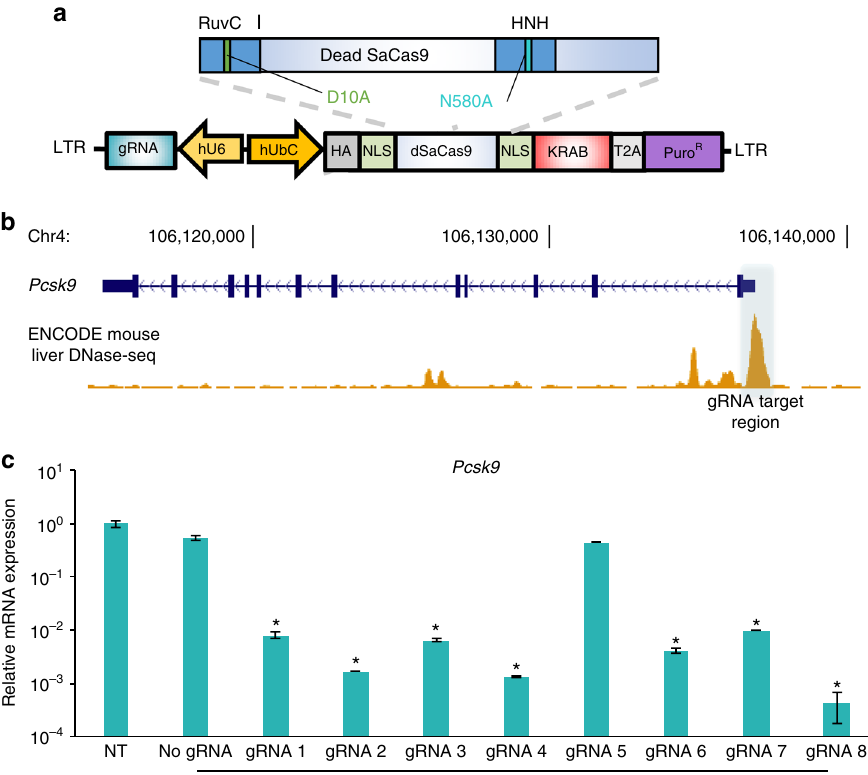
Fig. 1 Targeted gene silencing of endogenous Pcsk9 in vitro. a Deactivated S. aureus dCas9 was fused to a KRAB repressor motif and delivered by lentivirus for in vitro gRNA screening. The lentiviral vector also contained a puromycin resistance gene and a gRNA expression cassette. b A panel of eight S. aureus gRNAs were designed to target the accessible chromatin region of the mouse Pcsk9 promoter region in AML12 cells, a mouse hepatocyte cell line with high expression of Pcsk9 . An ENCODE wild-type mouse liver DNase I hypersensitivity-sequencing track is included to highlight the accessible chromatin region around the Pcsk9 transcription start site 38 . c Single gRNAs were screened for silencing ef fi cacy by qRT-PCR. (mean ± s.e.m., n = 2 biological replicates). P < 0.05 indicated by * compared with the non-transduced (NT) control (Student ’ s t-